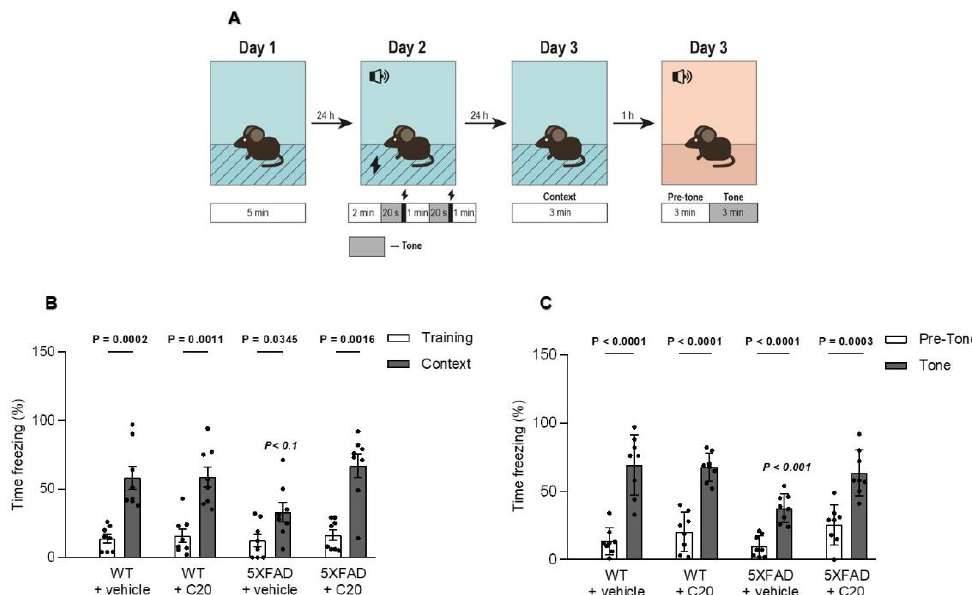
Figure 6. C20 improves impairment of fear conditioning in 6-month-old 5xFAD mice. ( A ) Schematic illustration of the fear conditioning paradigm. Habituation of mice in the chamber was performed on the first day. The next day, mice were conditioned with 2 tone and shock pairs. Contextual fear memories were tested 24 h later, followed by a tone test to evaluate cued fear memory (n = 8 mice per group). ( B ) Total freezing percentage during the contextual fear conditioning test of mice performed on day 3 of the test. ( C ) Total freezing percentage during the tone fear conditioning test of mice performed on day 3 of the test. All data represent the mean ± SEM. Sample distributions were assessed for normality (Shapiro–Wilk test) and homogeneity (Bartlett’s test). Regular P value indicates the significant differences (Mann–Whitney test ( B ) or t -test ( C )) between conditions (training/context or pre-tone/tone) in the same group, whereas italic P value indicates significant differences (Kruskal–Wallis test ( B ) or two-way ANOVA following Dunnett’s multiple comparisons test ( C )) between 5xFAD and the other groups of treatment.